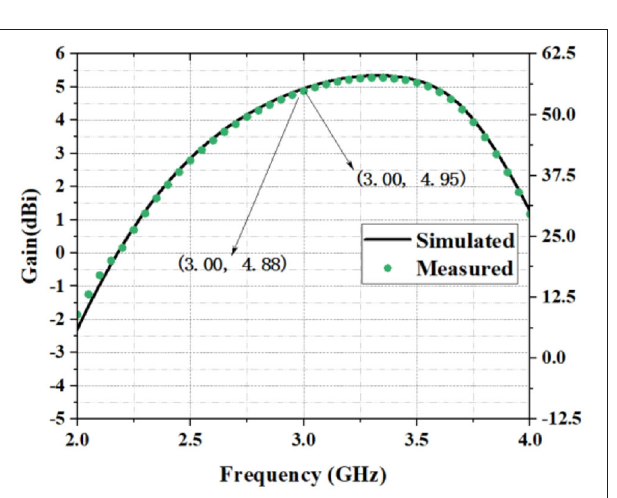
FIGURE 11 | Measured radiation gain of the proposed antenna.